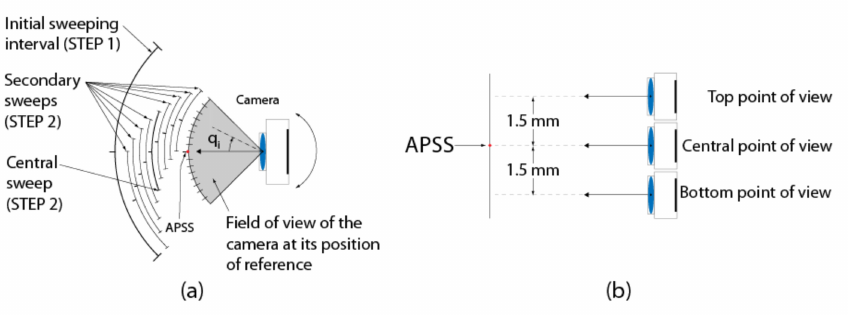
Figure 24. Secondary sweeps for tracking the speckle pattern. Top view ( a ). Side view ( b